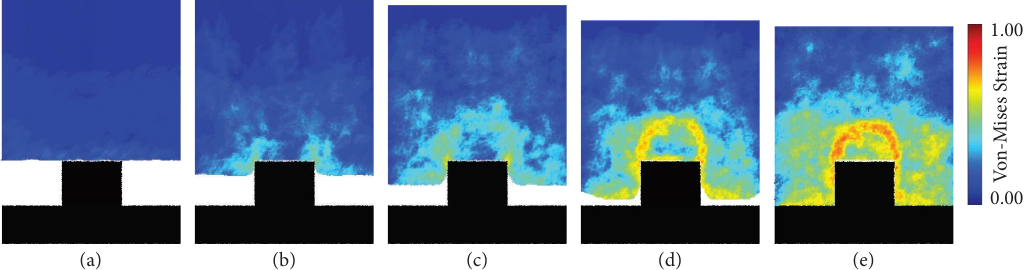
Figure 2: Evolution of imprinting process with tip-like pattern at 300K for mold displacement of (a) 0nm, (b) 1.8nm, (c) 2.4nm, (d) 3.1 nm, and (e) 4.5nm.